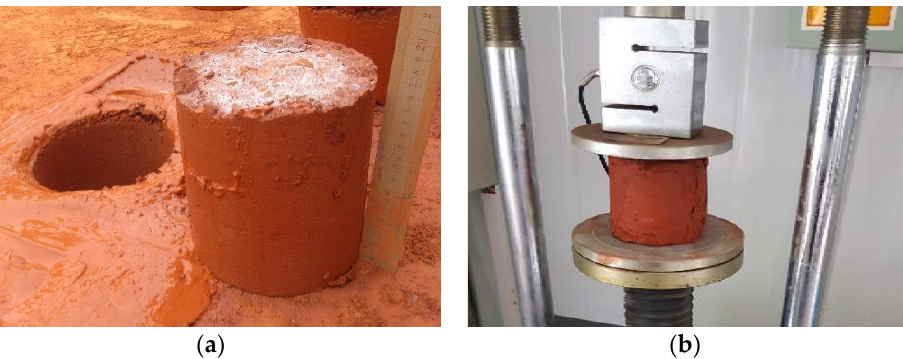
Figure 9. Site coring and testing of Bayer red mud Subgrade. ( a ) is field coring sample, ( b ) is unconfined compressive strength test of core sample.